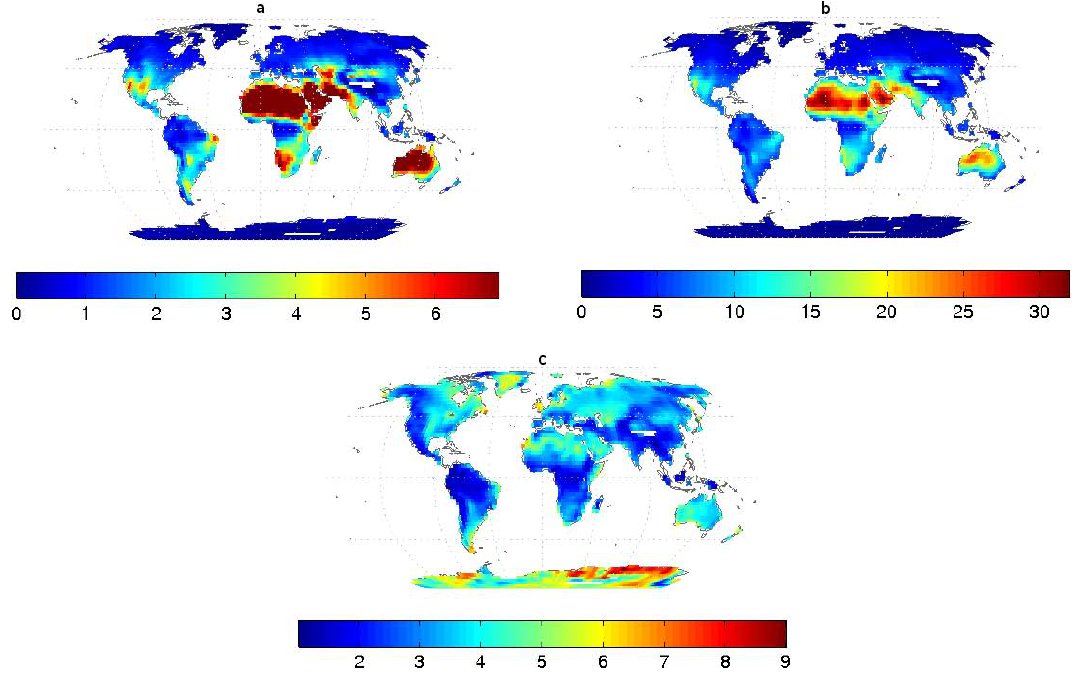
Fig. 1. Long-term averages (July 1983–June 2002). Top left: the bulk aerodynamic evaporation rate E a (mmday − 1 ) computed from wind speed, air temperature and humidity data from ERA-40. The E a values reach as high as 16 mmday − 1 over the Sahara. Top right: the VPD (mb) computed from air temperature and humidity data from ERA-40. Bottom: the wind speed U (ms − 1 ) from ERA-40.